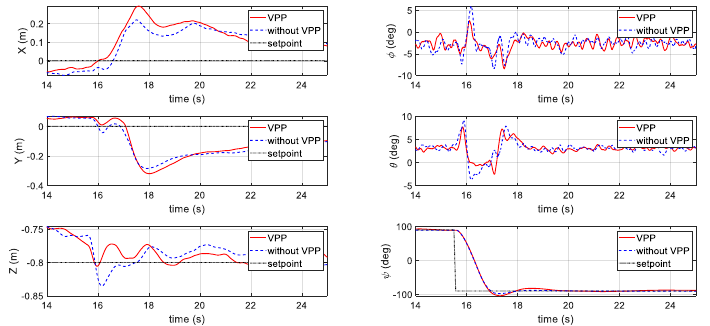
Figure 12. Results of the first flight test scenario with a step yaw command.